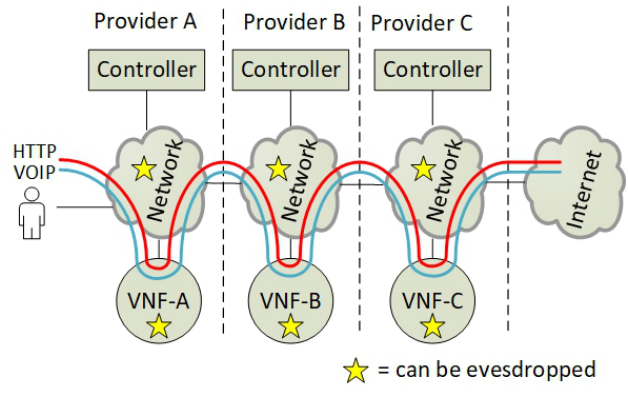
Figure 2. The adversary